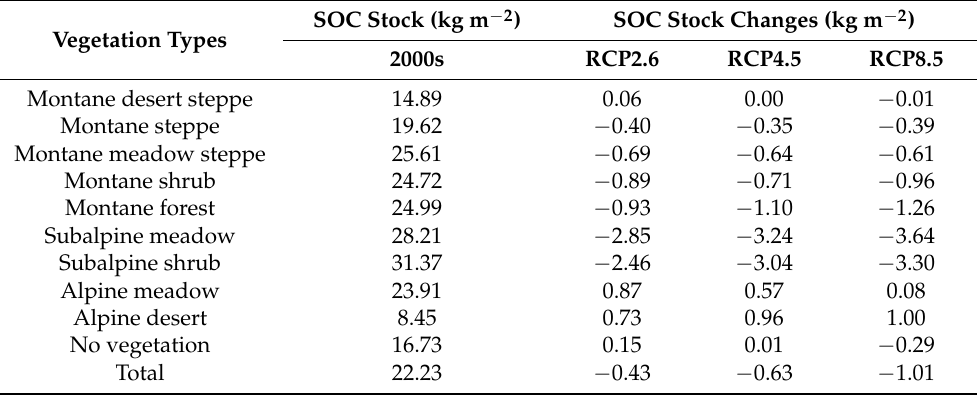
Table 3. Summary of SOC stock changes by vegetation types under different climate change scenarios from the 2000s to the